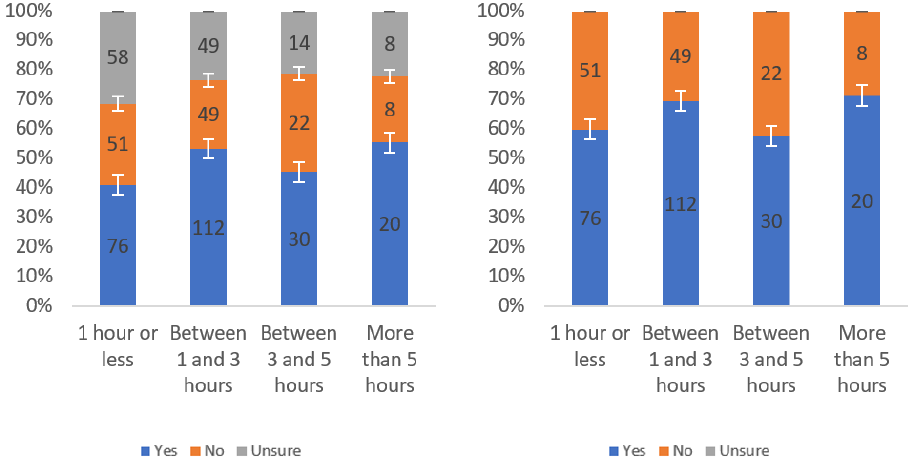
Figure A42. Responses regarding others’ willingness to review by internet usage level including ( left ) and excluding ( right ) unsure responses.